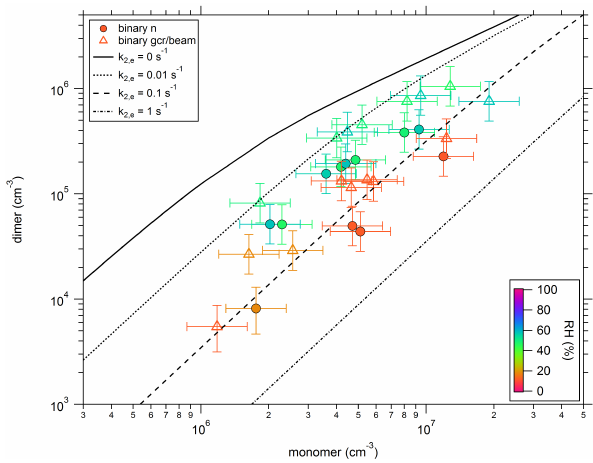
Figure 3. Simulated summed cluster concentrations at 223K and 20% RH ( k 2 , e = 5 . 8s − 1 and k 3 , e = 0 . 056s − 1 ; all larger evapora- tion rates are zero). The cluster concentrations are summed up to a certain number of sulfuric acid molecules in a cluster starting with the dimer concentration. The values on the x axis indicate the num- ber of sulfuric acid molecules in the largest cluster considered in the summation. All concentrations are normalized by the dimer concen- tration (at 2 × 10 7 cm − 3 monomer concentration).